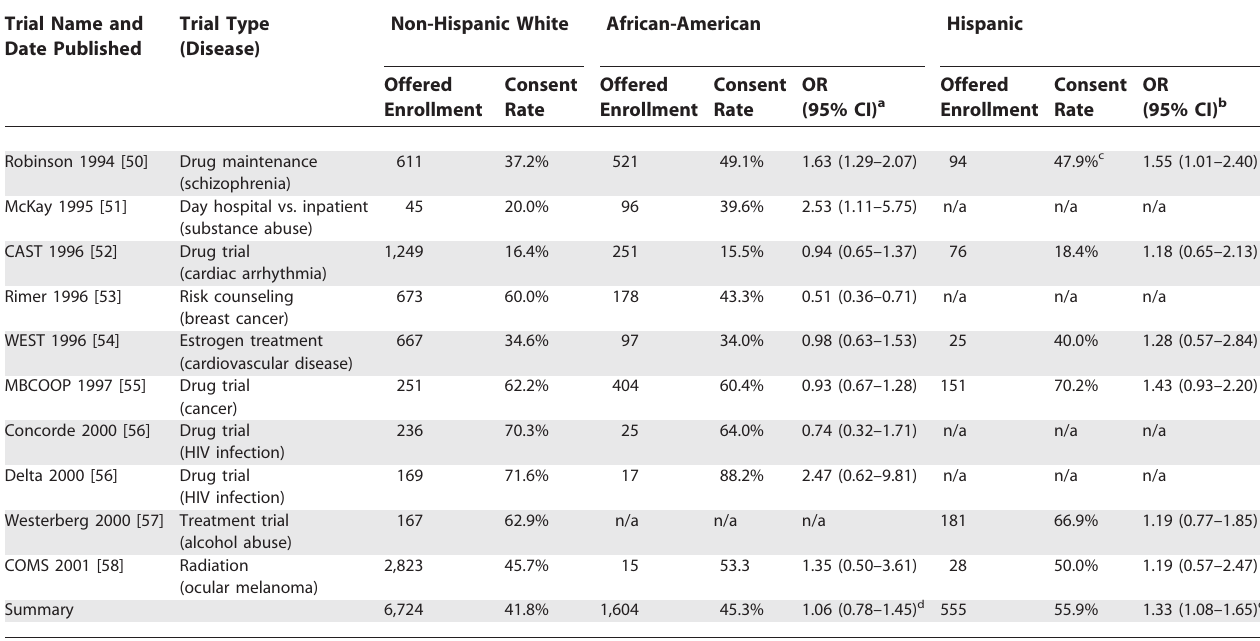
Table 2. Clinical Intervention Trials